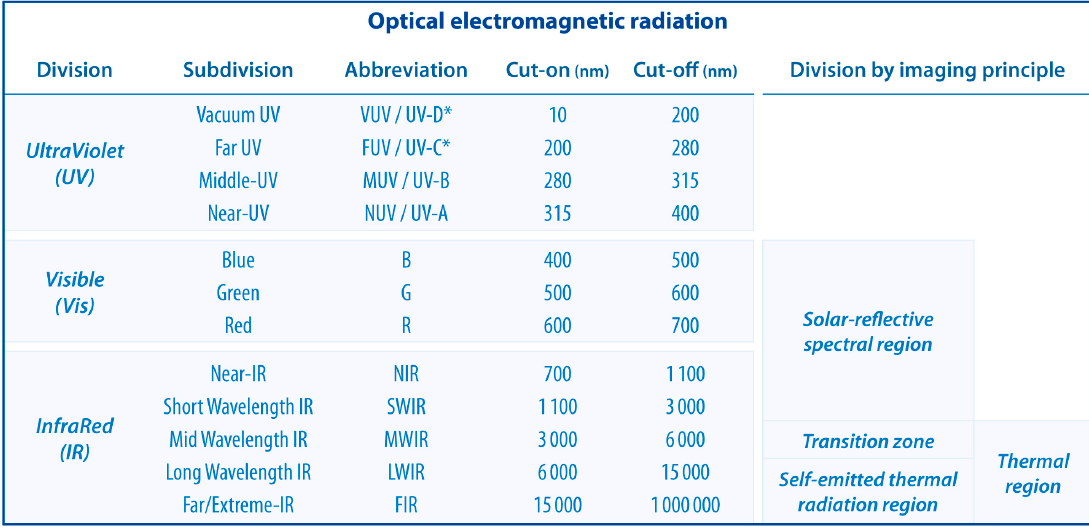
Figure 1. The divisions of the optical electromagnetic spectrum (* VUV does not perfectly correspond to UV-D. While VUV runs from 10 nm to 200 nm and FUV from 200 nm to 280 nm, UV-D encompasses the 10 nm to 100 nm region and UV-C the 100 nm to 280 nm zone).